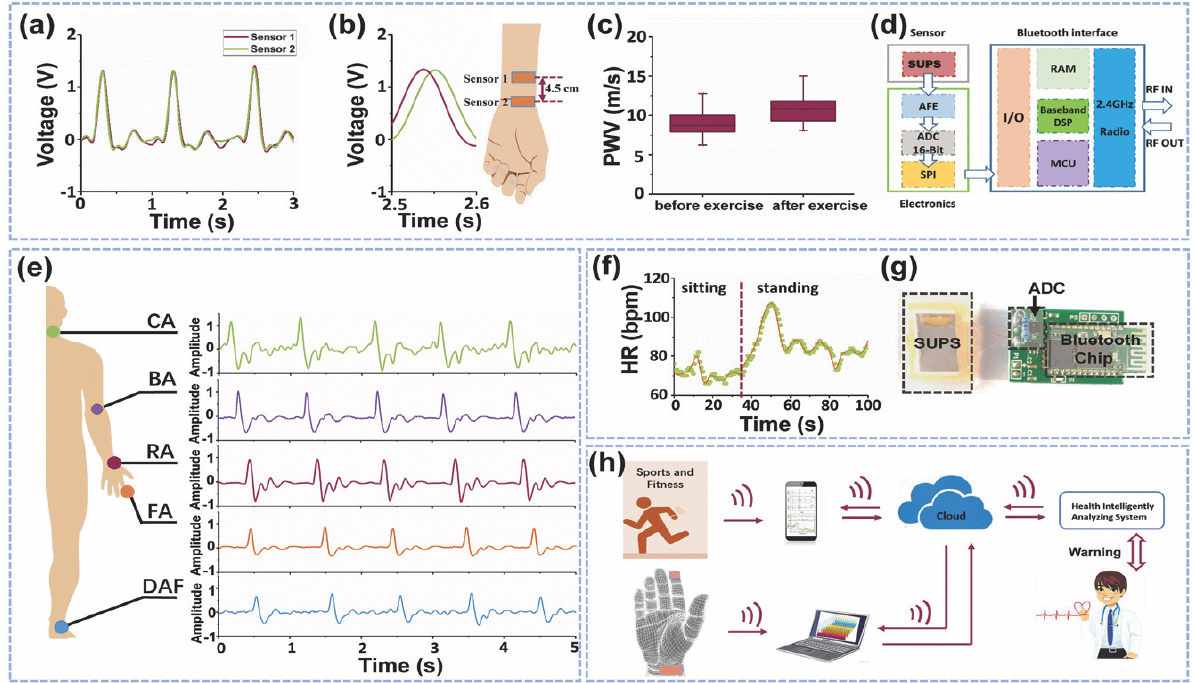
Figure 21. Electrical output variations on different artery regions from the human body and exercise activities, and the elements with big data and cloud of wireless pulse sensor system [111]. ( a ) Output voltage of two SUPS placed on different radial artery regions of a wrist. ( b , c ) Output voltage of two SUPS due to radial artery signals before and after an exercise activity. ( d ) Schematic representation of the components in the wireless pulse sensor system. ( e ) Output voltage of SUPS due to signals of different artery regions from a human body. ( f ) Variations of the heart rate during the activity of sitting and standing up. ( g ) Photograph of SUPS, ADC components, and Bluetooth interface of the wireless health monitoring system. ( h ) Schematic representation for online monitoring of cardiovascular signals of patients using the intelligent mobile diagnosis system. Reprinted with permis- sion from [111]. Copyright 2017, WILEY-VCH Verlag GMbH & Co. KGaA, Weinheim.